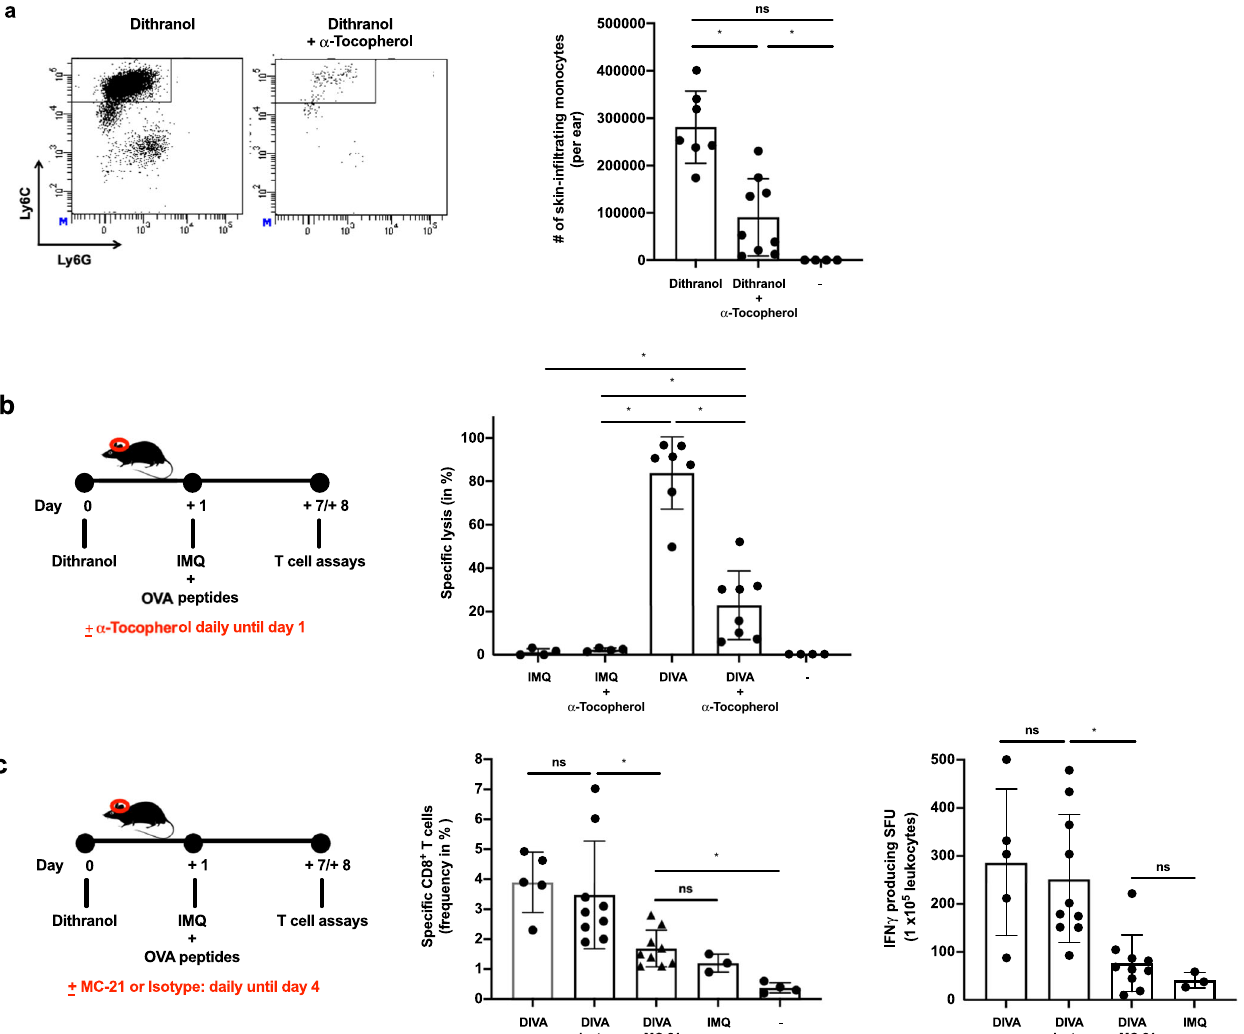
Fig. 7 Dithranol-induced monocyte recruitment is mediated by oxidative stress and is indispensable for the CD8 + T cell responses following DIVA. a Mice were treated with dithranol or IMQ for 24 h. When indicated, the radical scavenger α -tocopherol was administered (30 mg, i.p.). Treated murine ears were then digested with collagenase type IV in a GentleMACS dissociator. The total number of monocytes (MHCII − CD11b + Ly6C + Ly6G − ) was estimated by a scil veterinary excellence cell counter and fl ow cytometry (Supplementary Fig. 1d) ( n = 4 – 9). b C57B6/J mice were transcutaneously treated as depicted in the schematic overview. When indicated, the radical scavenger α - Tocopherol was administered (30 mg, i.p.) and c on day 7 the frequency of OVA 257 – 264 -speci fi c CD8 + T cells was determined (Supplementary Fig. 1a) and d on day 8 the speci fi c lysis of antigen-loaded target cells by OVA 257 – 264 -speci fi c CD8 + T cells was estimated (Supplementary Fig. 1c). e C57B6/J mice were treated as depicted in the schematic overview. When indicated, the CCR2-speci fi c, depleting antibody MC-21 or